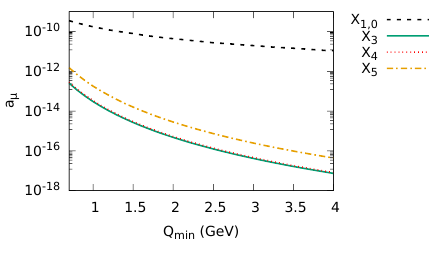
Figure 5. Contributions from X 1 , 0 , X 3 , X 4 and X 5 to a HLbL